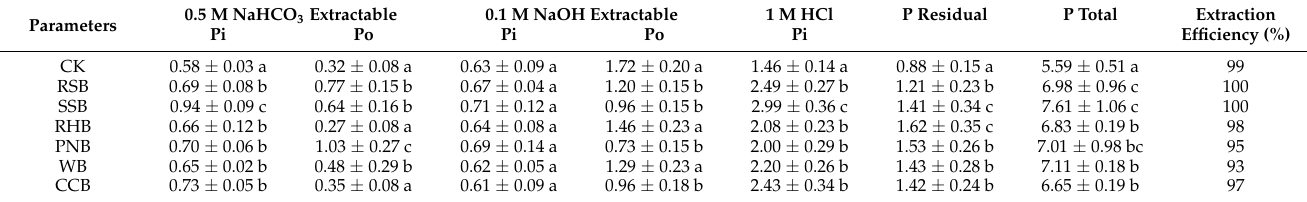
Abbreviations: CK: Control, RSB: Rice-straw biochar carrier, SSB: Soybean-straw biochar carrier, RHB: Rice-husk biochar carrier, PNB: Peanut-shell biochar carrier, WB: Wood biochar carrier, CCB: Corn-cob biochar carrier. Extraction efficiency for each of the P fractions was calculated from the sum of P fractions divided by total P and multiplied by 100. Pi (inorganic P) and Po (organic P), P residual, and P total. Different letters in columns indicate significant differences ( p ≤ 0.05) between treatments, while similar letters indicate non-significant